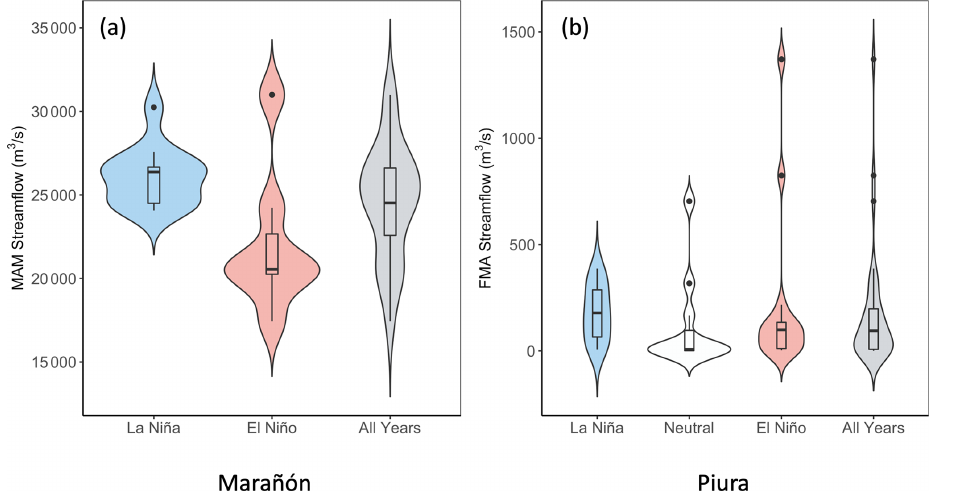
Figure 2. Violin plots of seasonal streamflow by ENSO phase. For the Marañón River at San Regis ( n = 19), 12 historical years are classified as La Niña conditions (MEI ≤ 0) and 7 are classified as El Niño conditions (MEI > 0). For the Piura River at Puente Sánchez Cerro ( n = 36), 11 years are classified as La Niña (MEI ≤− 0.5), 11 as neutral ( − 0.5 < MEI < 0.5), and 14 as El Niño conditions (MEI ≥ 0.5).